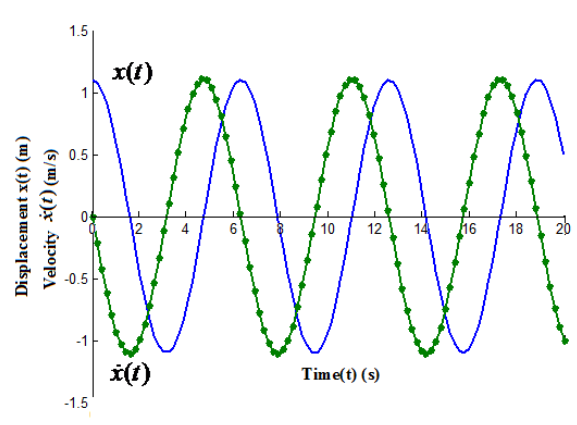
Fig. 2 Plot of displacement and velocity for oscillator Eq. (26) with weak nonlinearity and small amplitude oscillations l = 1 . 1 and µ = 0 . 1